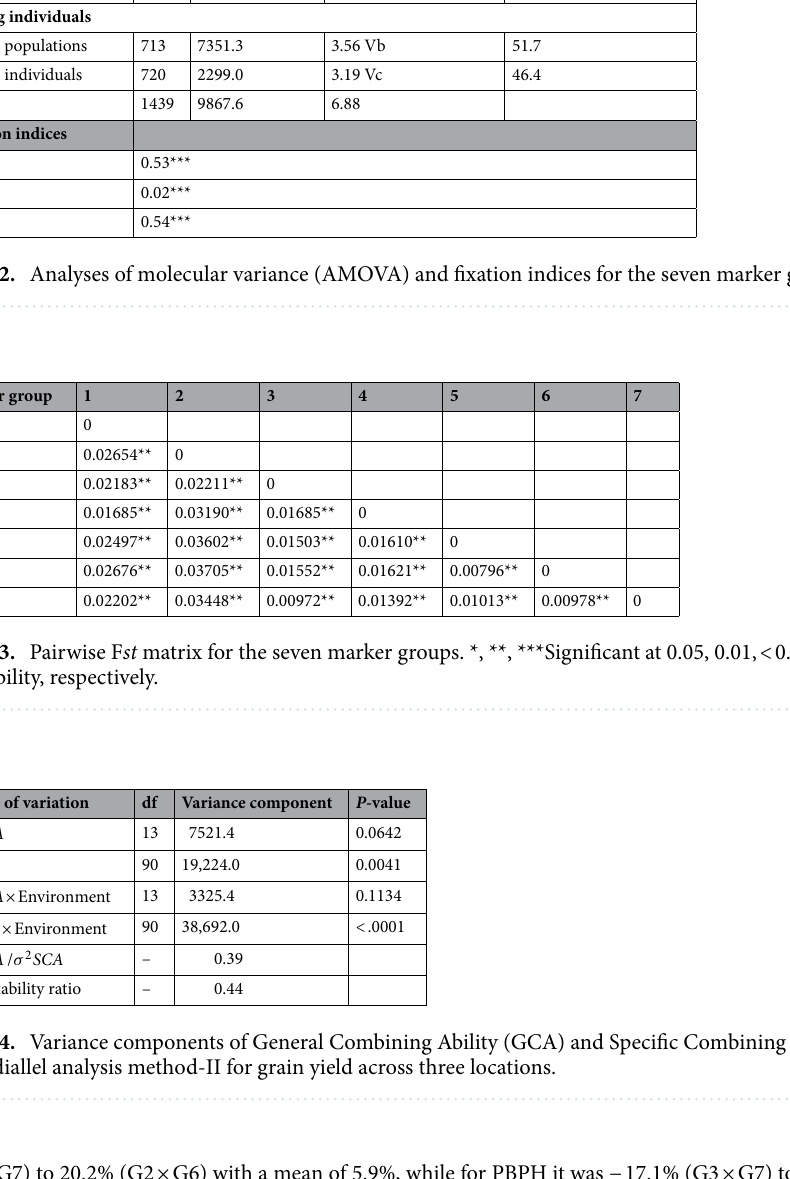
the 91 population hybrids, 46 hybrids had significantly positive heterosis over OPV check ICTP 8203, whereas only 1 hybrid had positive heterosis over hybrid check ProAgro 9444. There was significant negative but low correlation ( r = − 0.34, P < 0.001) between grain yield of population hybrids and GD between parental popula- tions (Table 9). However, low positive correlation was found between grain yield of population hybrids and mean grain yield of parental lines ( r = 0.20, P < 0.06) (Table 9). Heterotic pool formation. Hybrids of the G2 × G6 marker group crosses had the highest mean grain yield (2462 kg ha −1 ), PBPH (6.8%) and PMPH (20.2%) followed by marker group crosses of G2 × G5, G4 × G5, G1 × G4, G1 × G5 and G4 × G6 (Table 6). The lowest yielding hybrids were from G3 × G7 (1836 kg ha −1 , − 17.1% PBPH, − 8.5% PMPH, − 156.1 SCA and − 116.7 GCA). Majority of marker group crosses involving the G3 group had below average grain yields, low heterosis and negative combining ability estimates (Table 6).